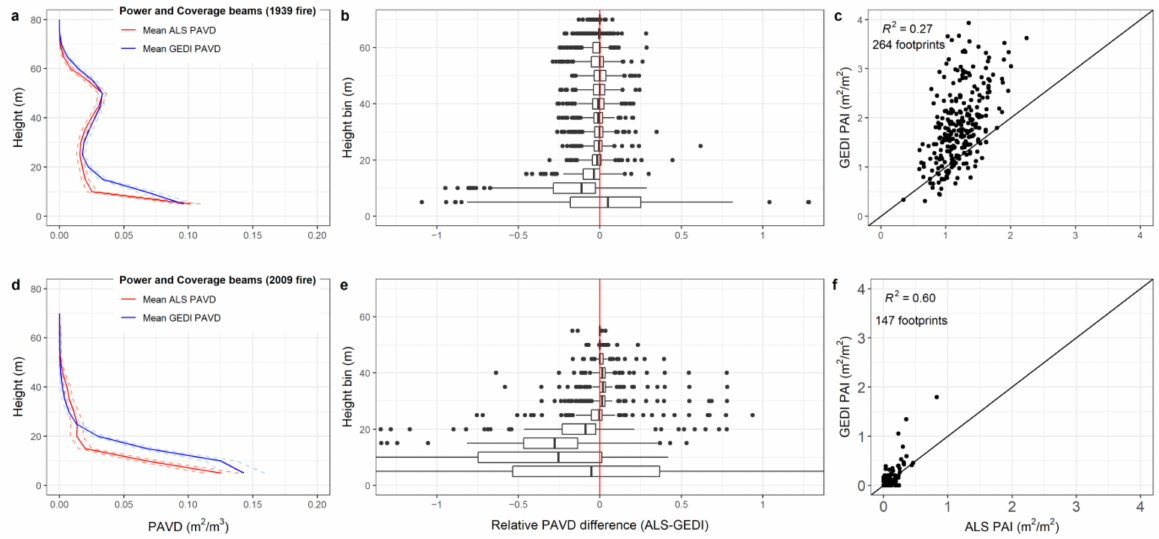
Figure 9. Mean vertical PAVD profile of ALS and GEDI, for footprints from 1939 fire age-class ( a ) and 2009 fire age-class ( d ); difference between GEDI and ALS values in 5 m canopy height bins for 1939 age-class ( b ) and 2009 age-class ( e ); scatter plot of ALS and GEDI PAI values for footprints within the 1939 fire age-class ( c ) and the 2009 fire age-class ( f